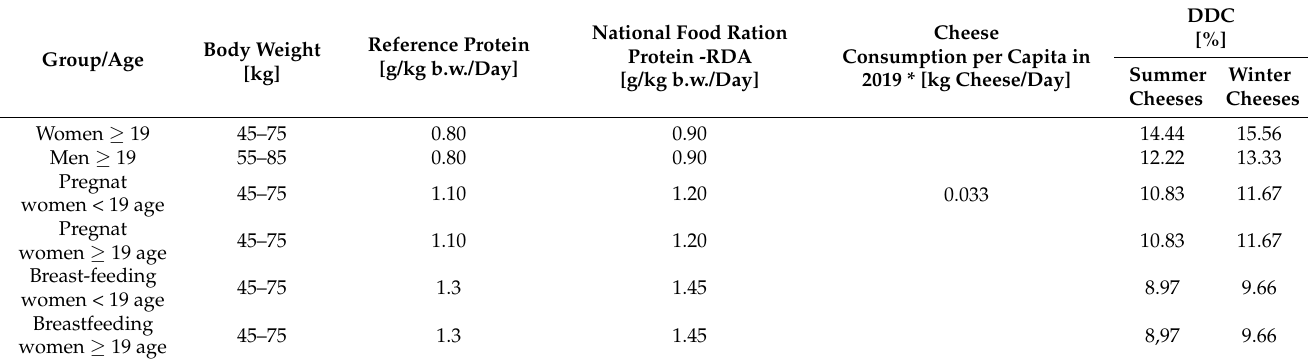
Table 1. Covering the daily protein requirements after eating a portion of